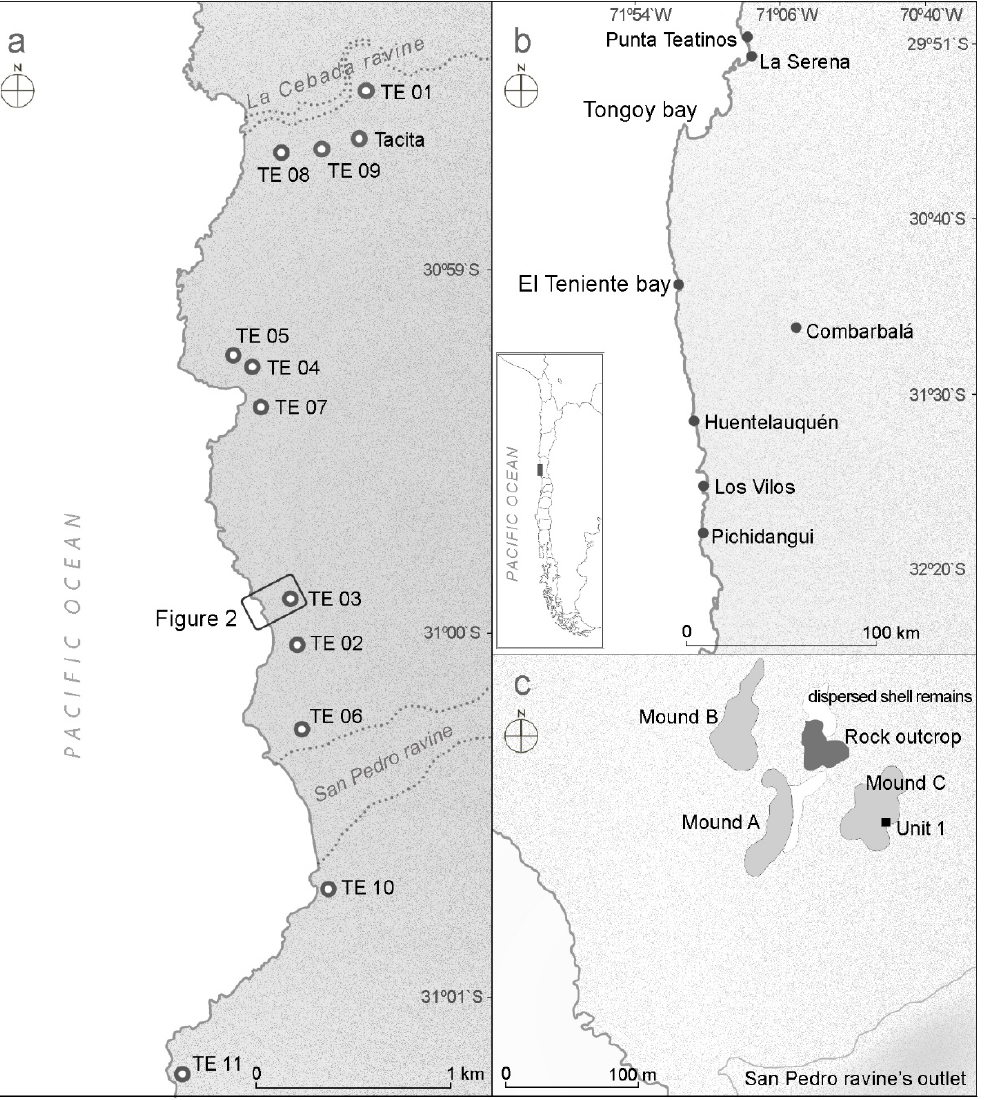
Figure 1. Map of the study area showing the regions and sites discussed in this article: ( a ) El Teniente Bay; ( b ) coastal region from 31° to 32° S; ( c ) Quebrada San Pedro Norte site (TE06) showing the relationship between shell mounds.